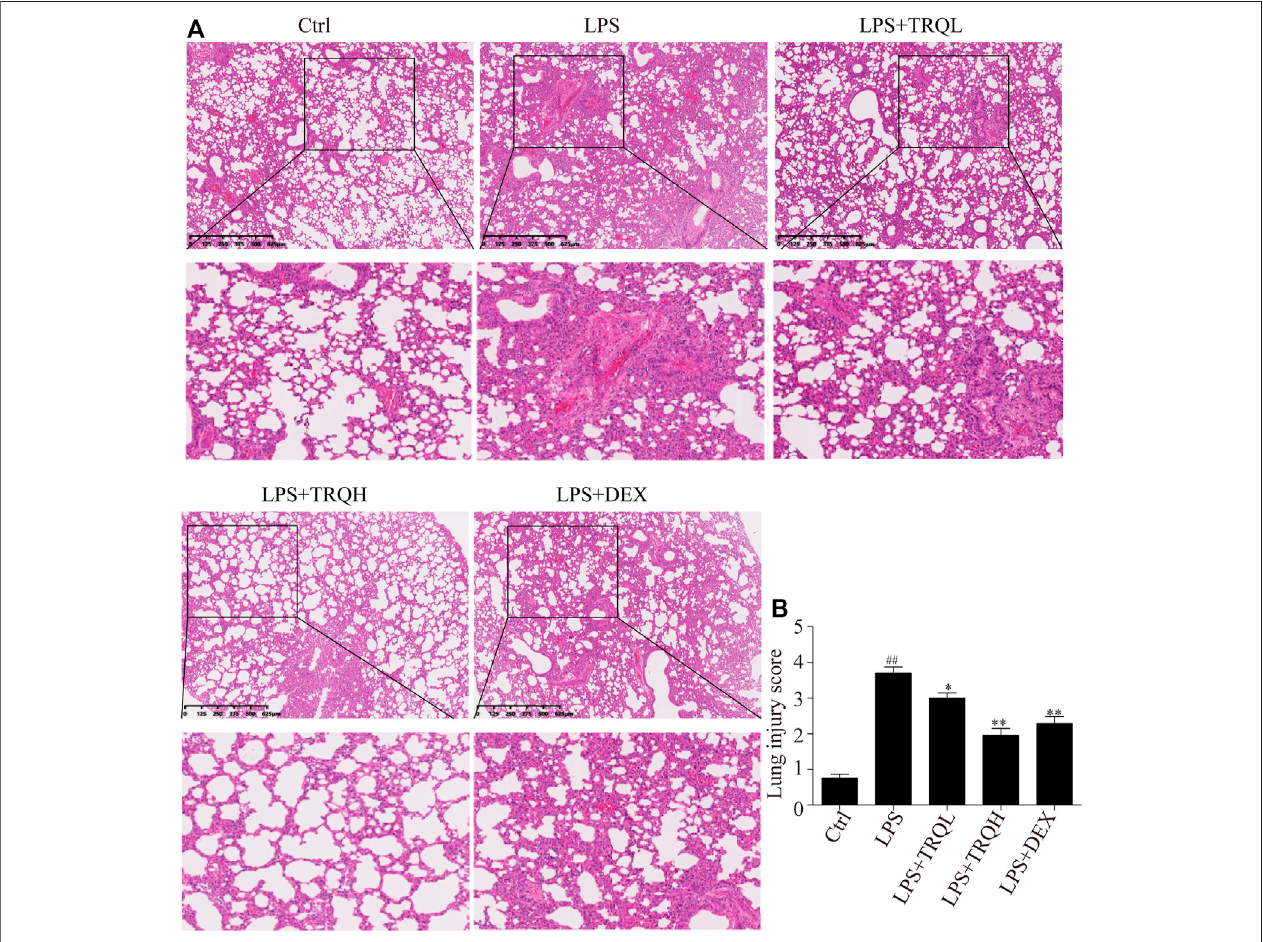
FIGURE 2 | TRQ alleviated lung histopathological changes in LPS-induced ALI mice. (A) Representative H&E staining of lung tissues. (B) Quanti fi cation of lung injury. n (cid:2) 5. ## p < 0.01 vs. Ctrl group; *p < 0.05 and ** p < 0.01 vs. LPS group.